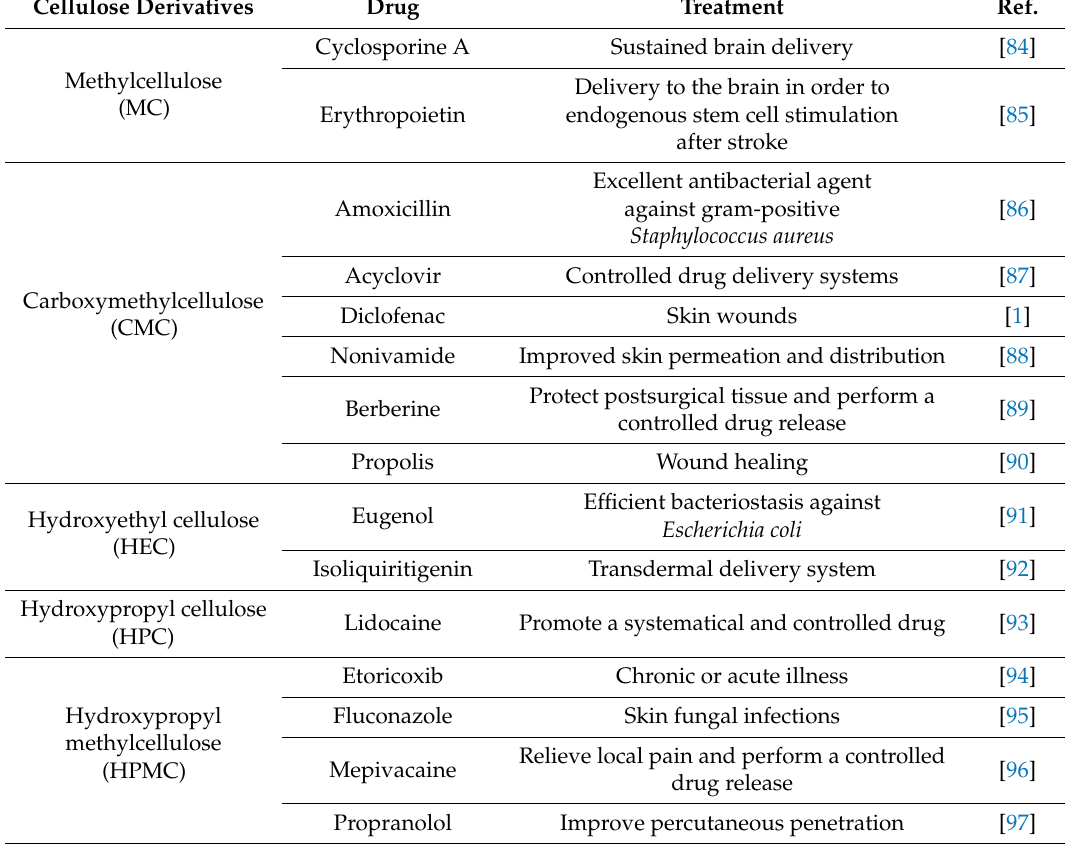
Table 2. Cellulose derivative-based hydrogel as drug-delivery systems.